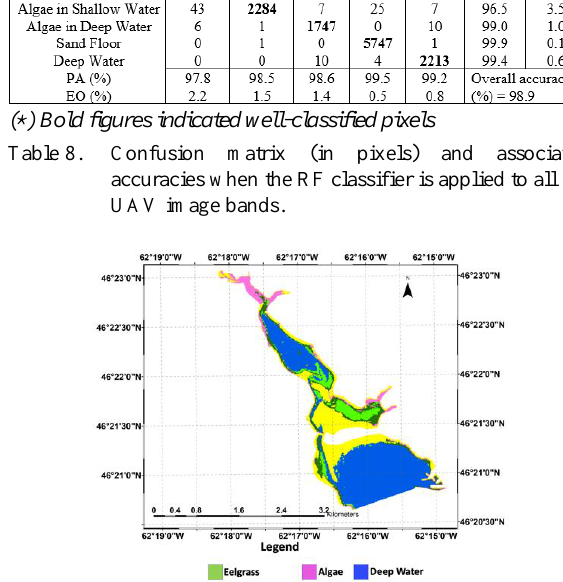
Figure 9. Classified image produced with the RF Classifier applied to all the bands of the Sentinel-2 image.